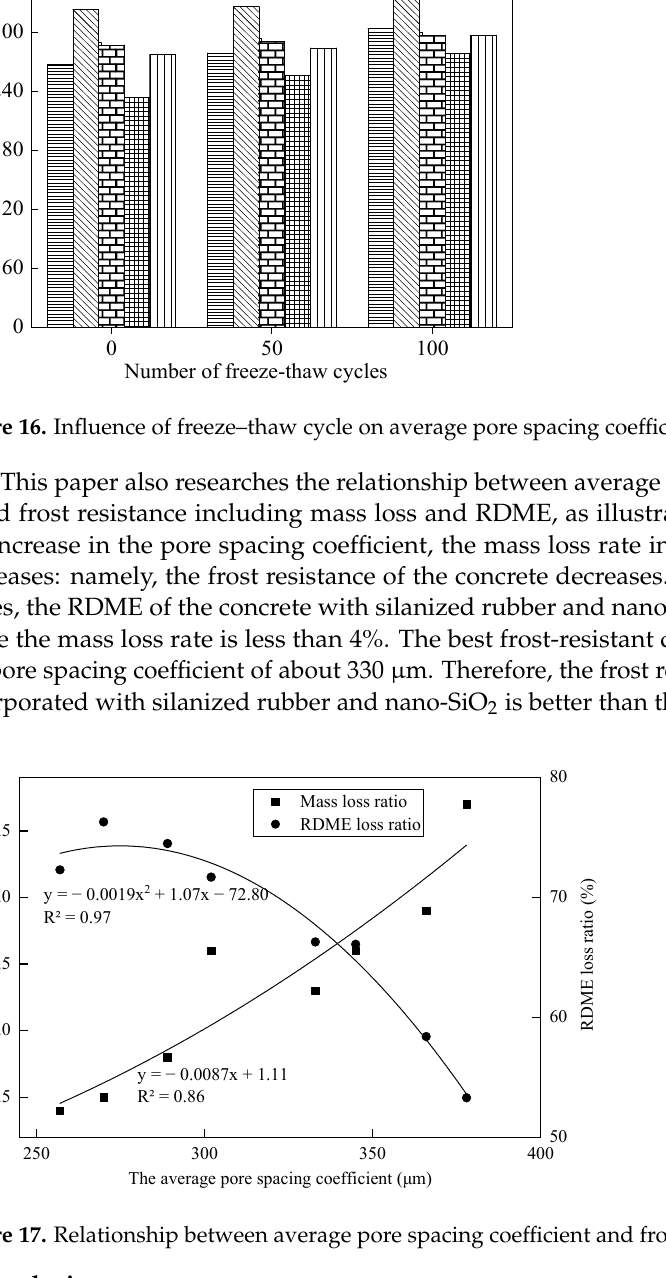
Figure 15. Average pore spacing coefficient of concrete.